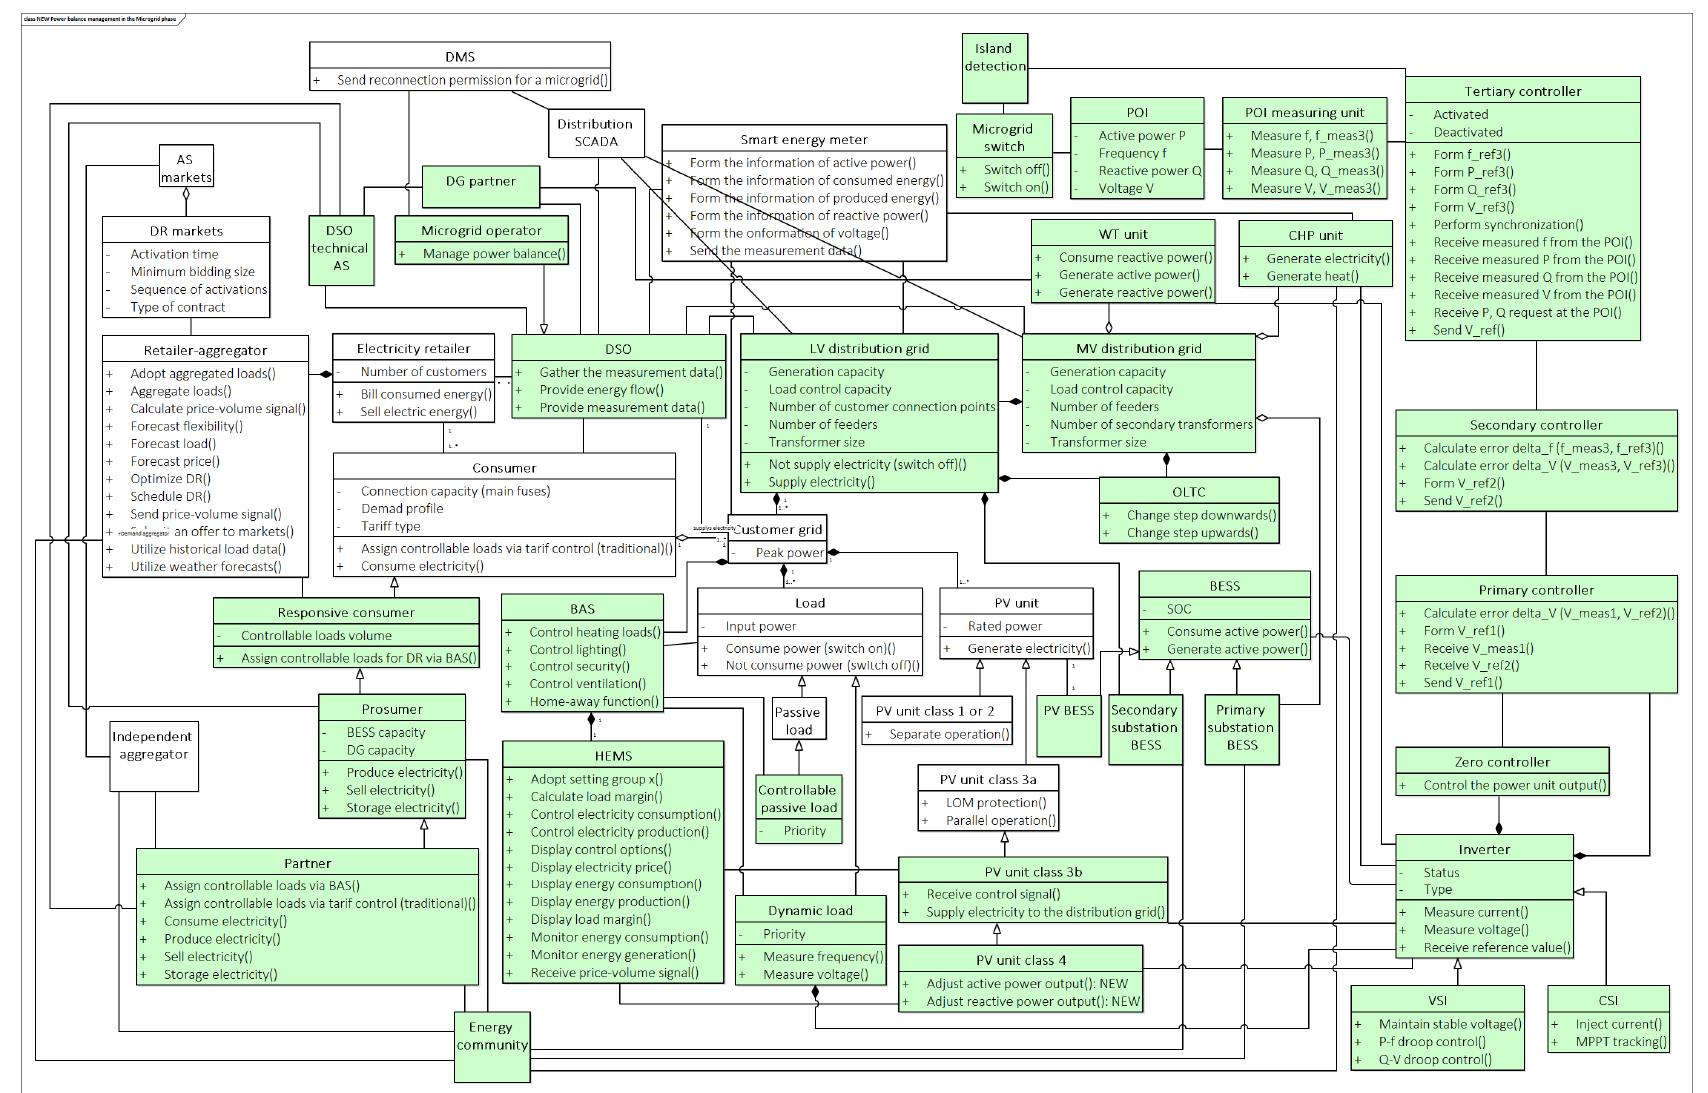
Figure A2. Class diagram of power balance management of the microgrid phase.